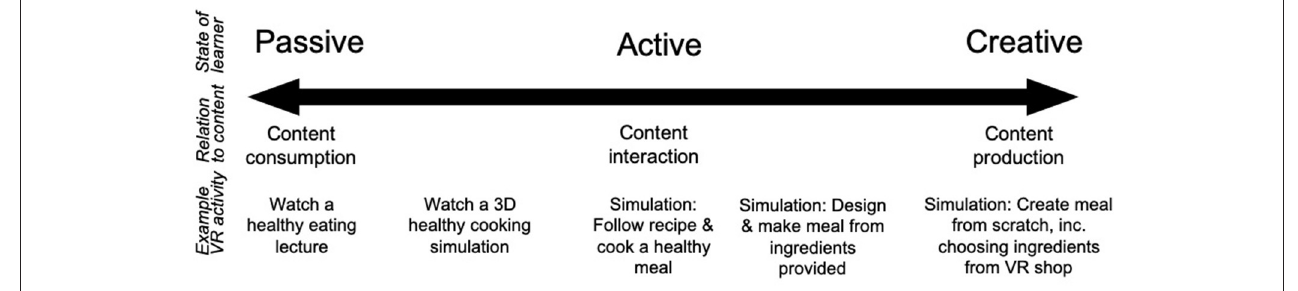
FIGURE 1 | A scale of relating to the learning theory of